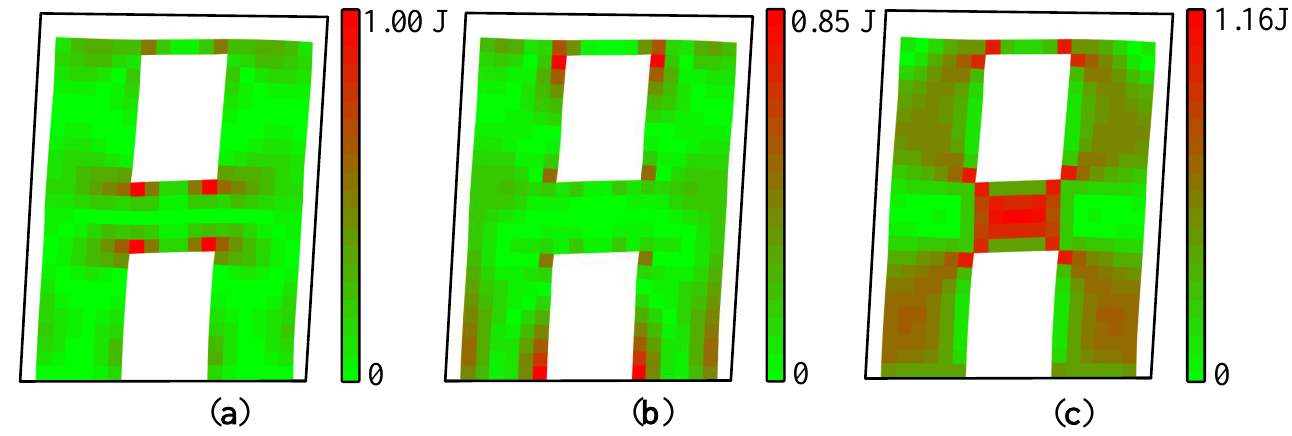
Figure 8. Modal strain energy cloud diagrams of A2: ( a ) X-direction modal normal strain energy, ( b ) Y-direction modal normal strain energy, and ( c ) modal shear strain energy.